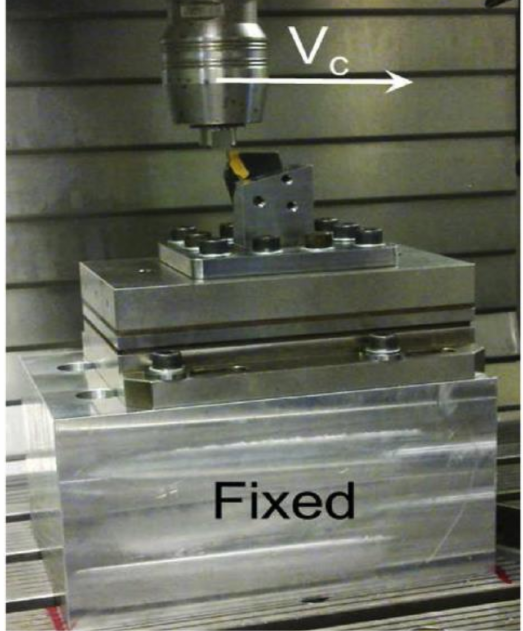
Figure 3. Cutting configuration on the milling machine [32].